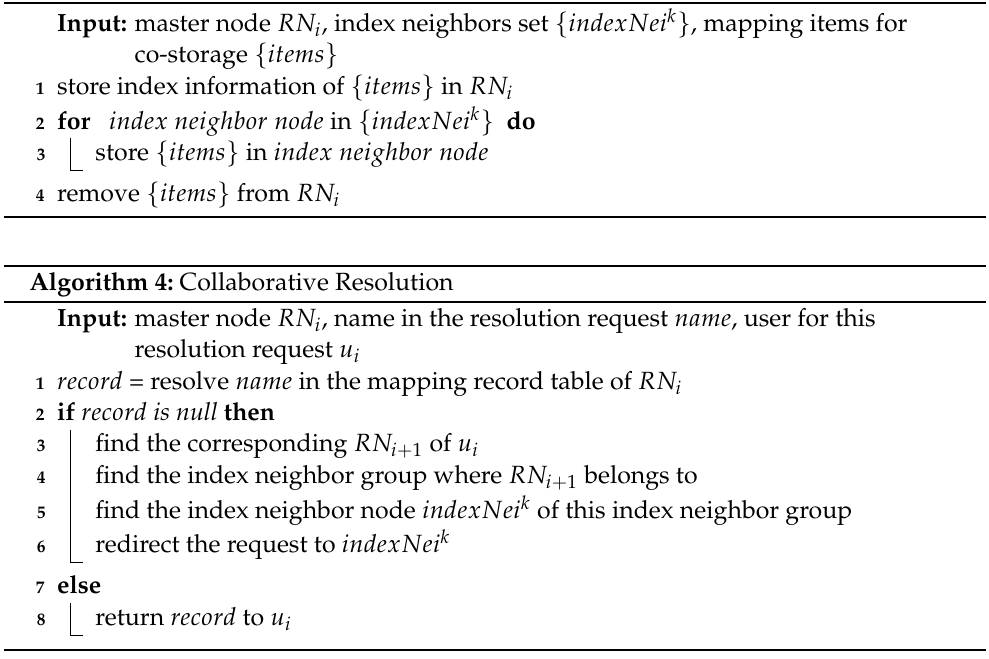
Algorithm 3: Collaborative Storage